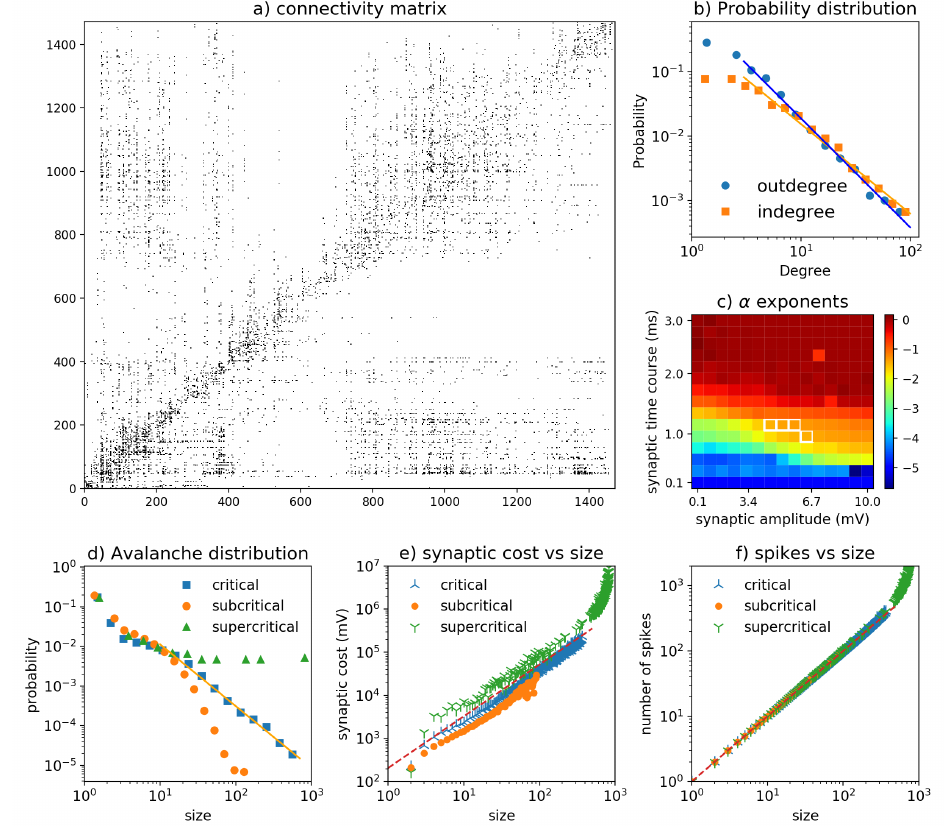
Figure 7. Critical dynamics and metabolic cost in a Drosophila connectome. ( a ) Matrix connectivity. ( b ) Indegree and outdegree distributions follow power-law functions: γ = 1.4 and γ = 1.7, respec- tively. ( c ) Heatmap of scaling exponents α . ( d ) Critical dynamics at w = 4.3 mV and τ = 1.1 ms. Subcritical dynamics: w = 3.6 mV and τ = 0.7 ms, supercritical dynamics: w = 7.8 mV and τ = 1.5 ms. ( e ) Synaptic cost vs. size. ( f ) Spikes vs.